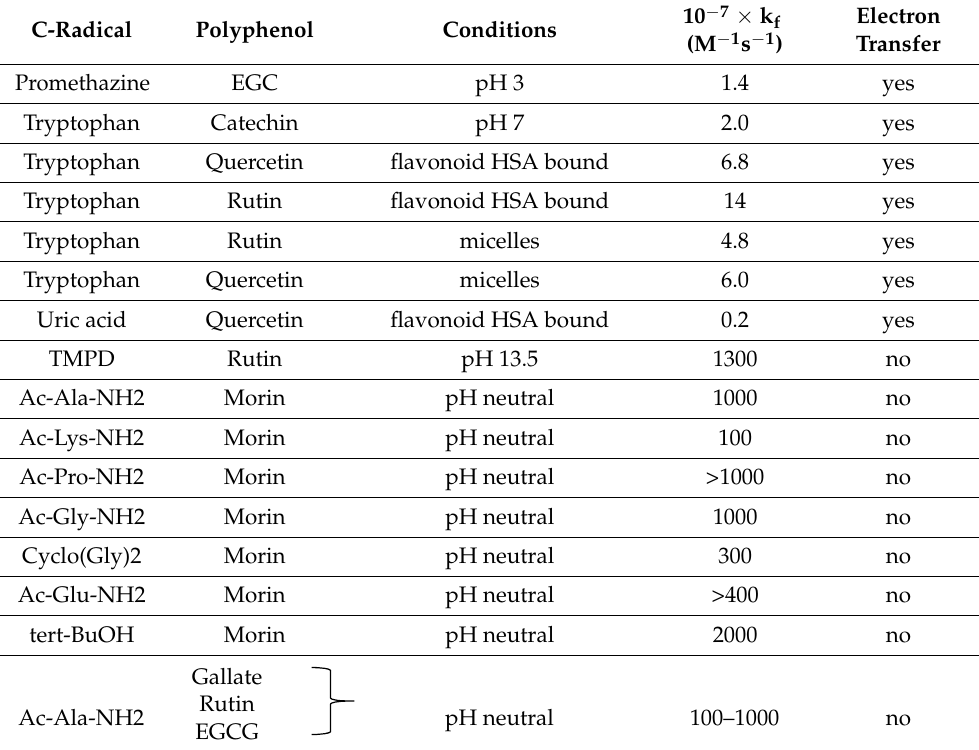
Table 1. Rate constants of repair of the carbon radicals by flavonoids and a metabolite.